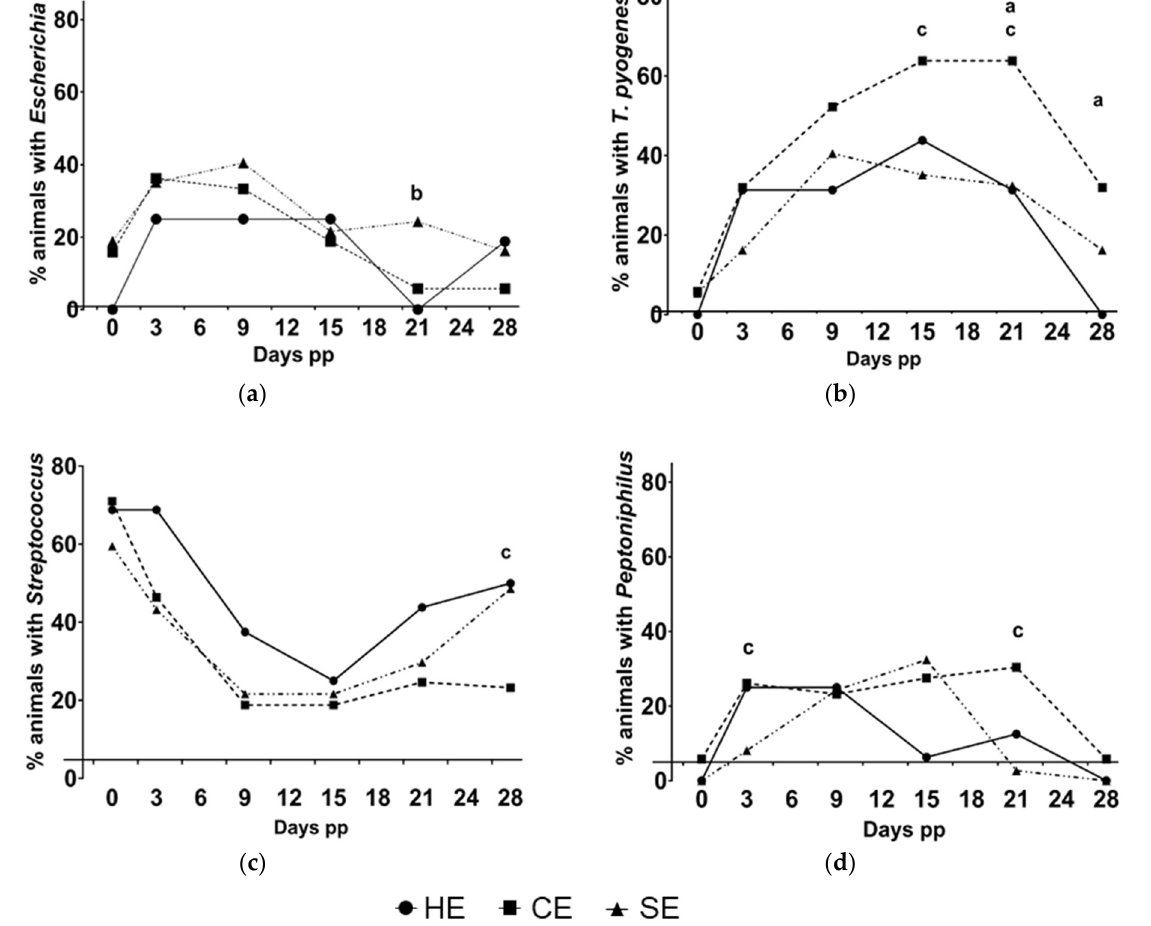
Figure 4. Percentage of healthy cows (HE, n = 16) and cows with clinical (CE, n = 69) and subclinical (SE, n = 37) endometritis positive for ( a ) Escherichia , ( b ) T. pyogenes , ( c ) Streptococcus spp., and ( d ) Peptoniphilus spp. at the day of calving (day 0) and on days 3, 9, 15, 21, and 28 postpartum. a, signif- icant difference between CE and healthy animals; b, significant difference between SE and healthy animals; c, significant difference between SE and CE animals; p < 0.05, respectively.